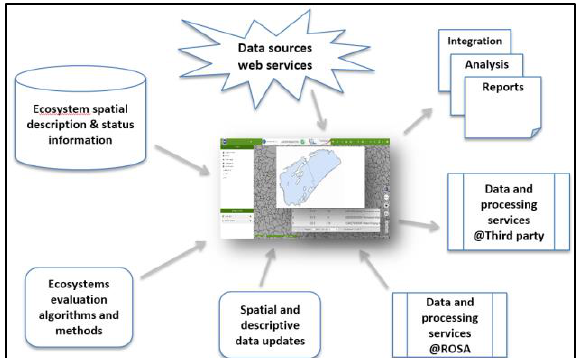
Figure 3. N4D-Decision Support System (DSS)